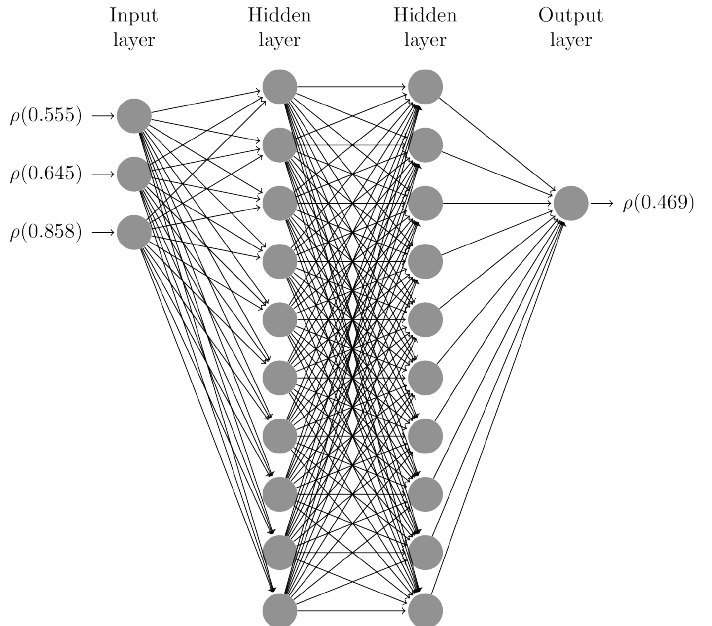
Figure 6. Topology of the ANN with one input layer taking 0.555, 0.645, and 0.858µm reflectance values, the 0.465µm.